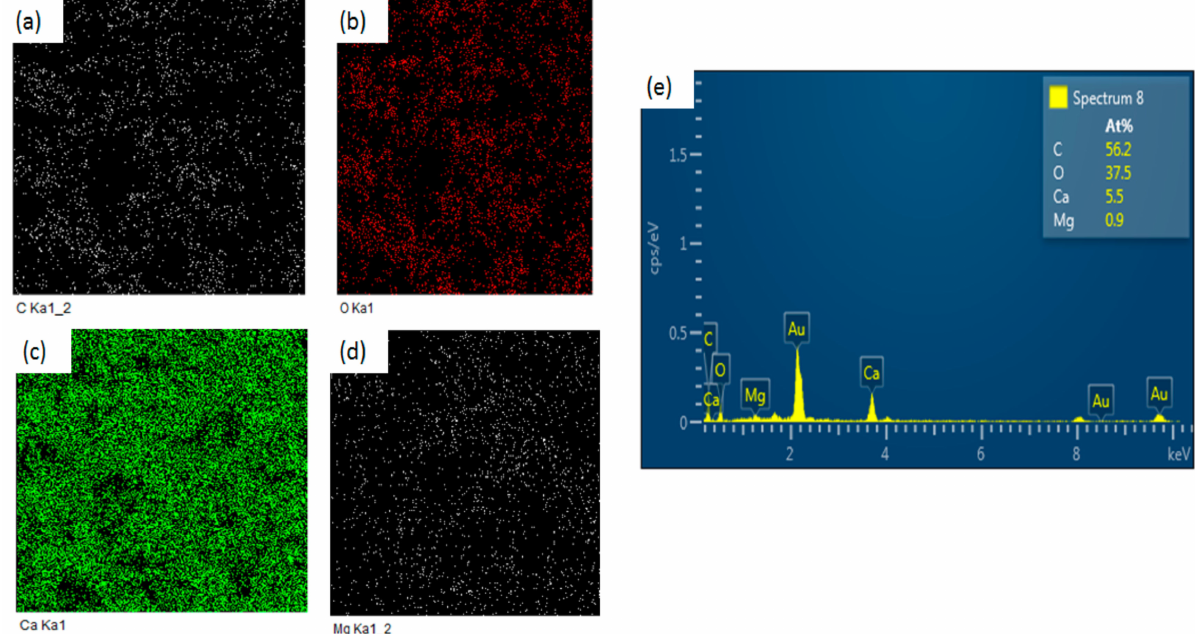
Figure 4. The elemental X-ray mapping images for ( a ) = C, ( b ) = O, ( c ) = Ca, and ( d ) = Mg corresponding to the 10-MCC sample. ( e ) EDS spectrum for the region marked by a circle in 3-1 ( c